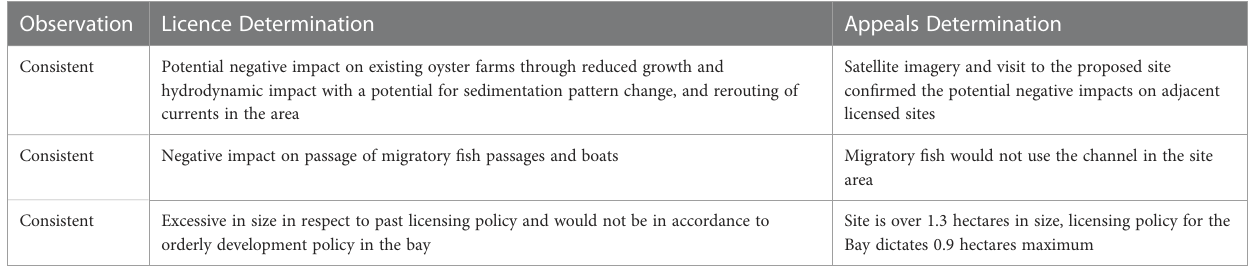
TABLE 5 Licence and appeal determination for oyster cultivation in trawbreaga